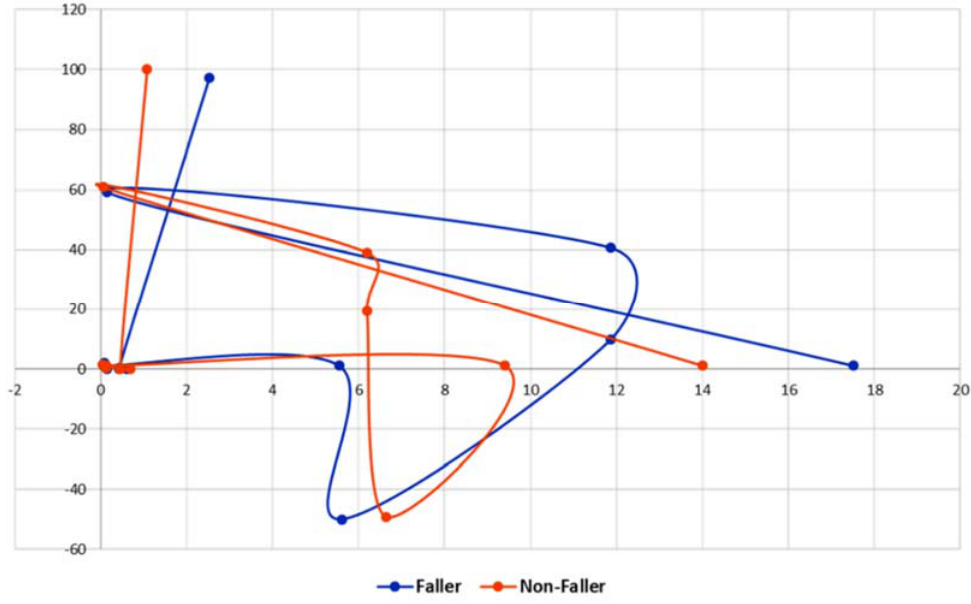
Symmetry of stance and swing phases: symmetry calculated based on time differences between the respective left and right phases for a given outcome - Single support time: time at which only one foot is on the floor (in seconds) - Heel ‐ strike angle and toe ‐ off angle: angle of the forefoot during the specific time points (in °) - Foot circumduction: foot circumduction describes the swing width (distance between an imaginary straight walking line of foot and the point of maximum actual deflection of the respective foot during the swing phase) of the respective leg (in meters)